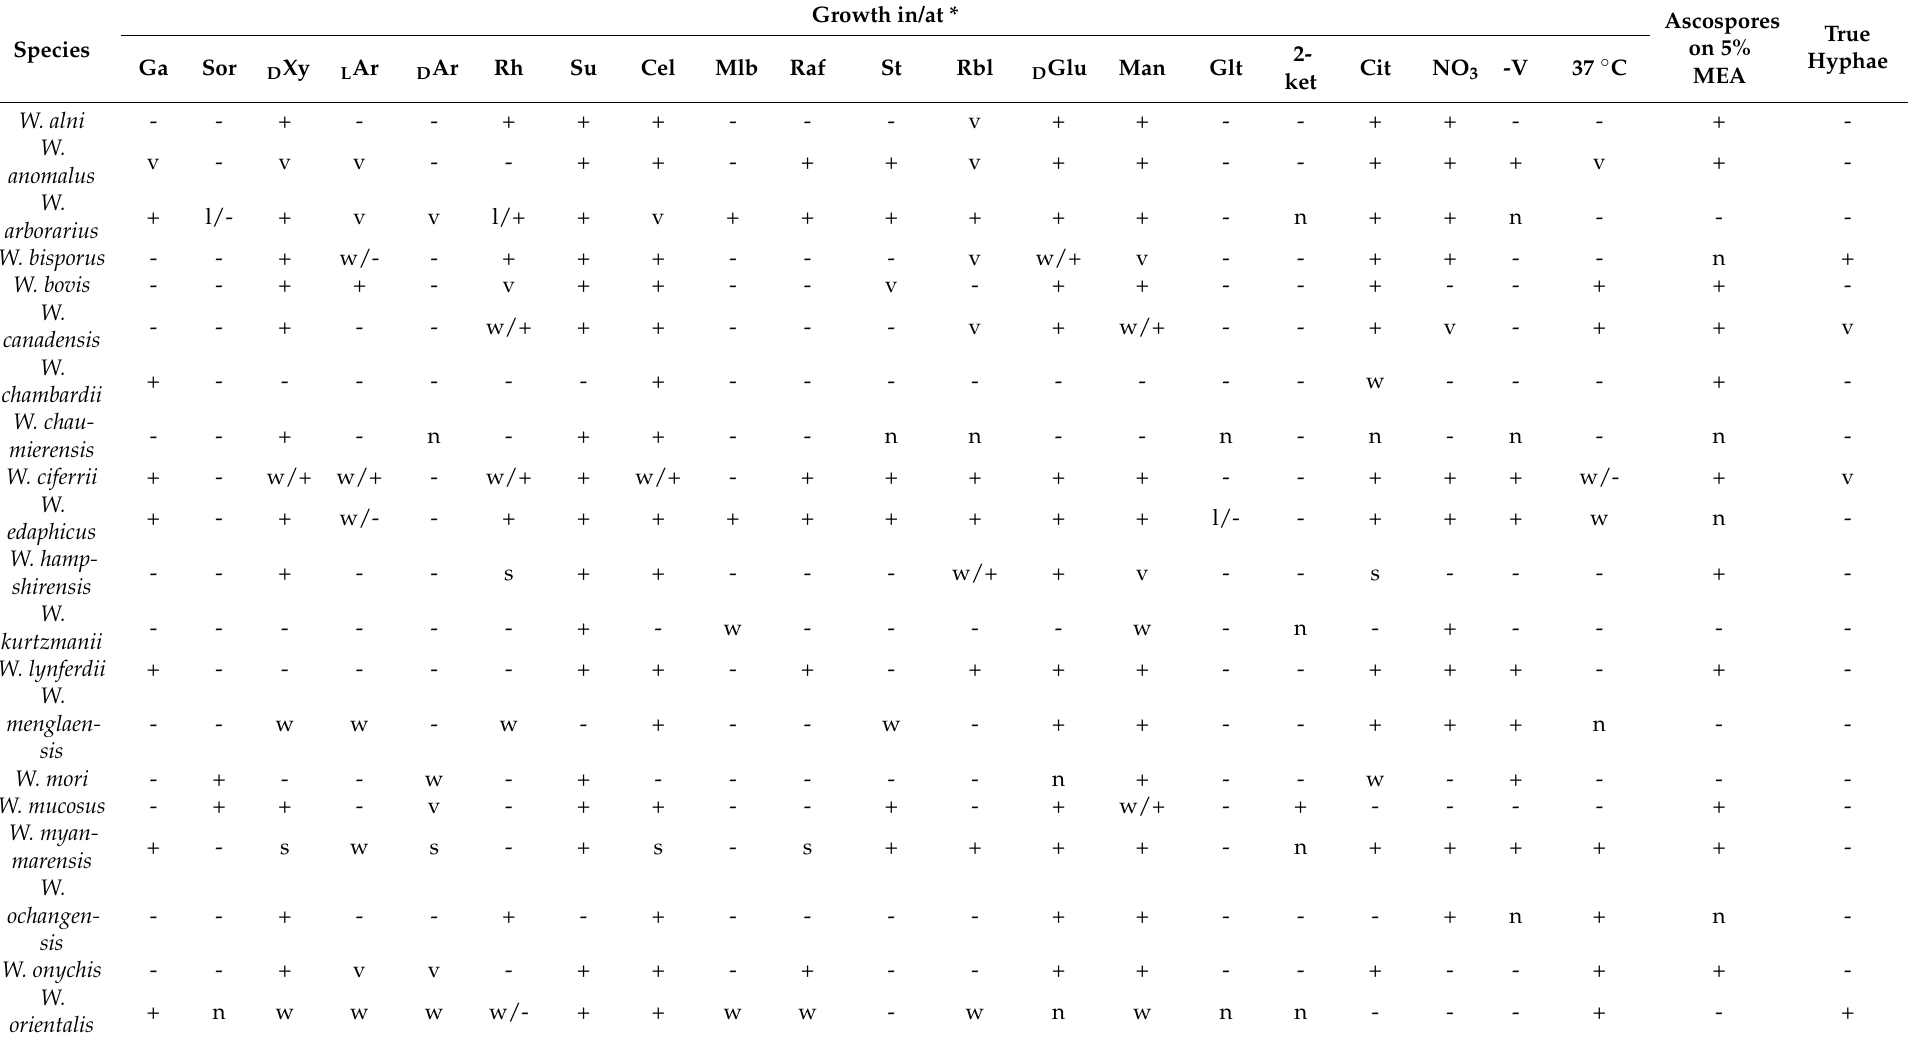
Table 3. Key characteristics of species assigned to the genus Wickerhamomyces